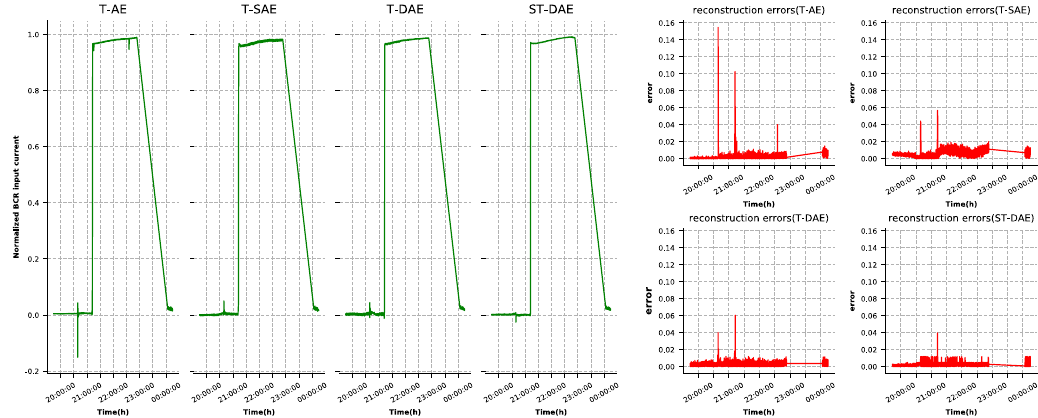
Figure 7. BEA reconstruction results and errors.